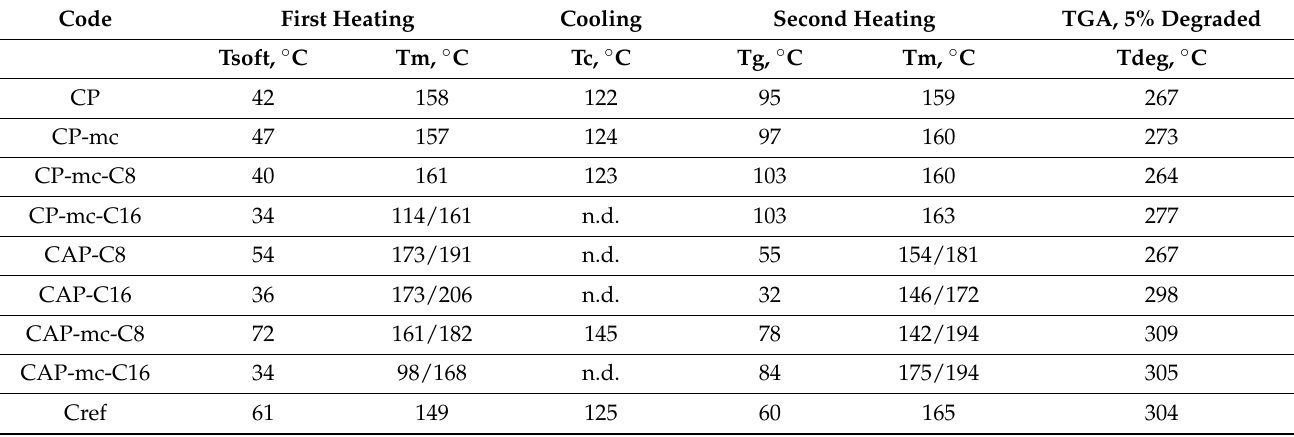
Figure 2. Injection molded test bars. Table 3. Results from DSC and TGA analytics. DSC-results are from the first heating, cooling and second heating cycles for the compounded granules. TGA results are for the temperature, where 5% of the material is